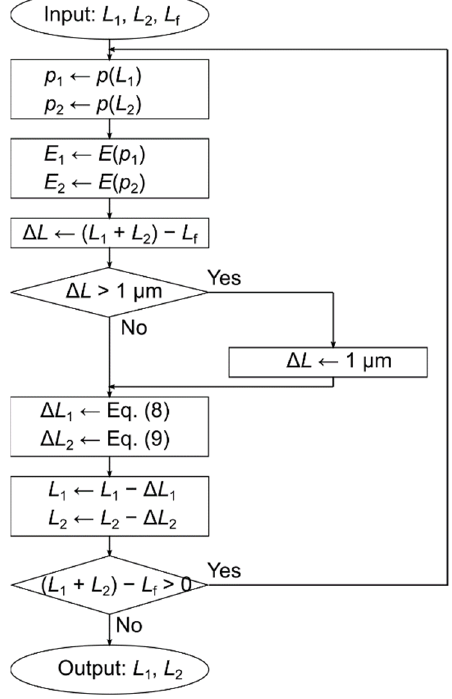
Figure 2. Flowchart of calculating compression. Inputs are L 1 : thickness before compression of layer 1, L 2 : thickness before compression of layer 2, and L f : total thickness after compression. Output is L 1 : thickness of compression of layer 1 and L 2 : thickness of layer 2 after compression. Function p is used to find the porosity from the thickness. The porosity is derived by calculating the bulk density from the thickness and then applying Equation (10). Function E is used to obtain Young’s modulus from porosity.